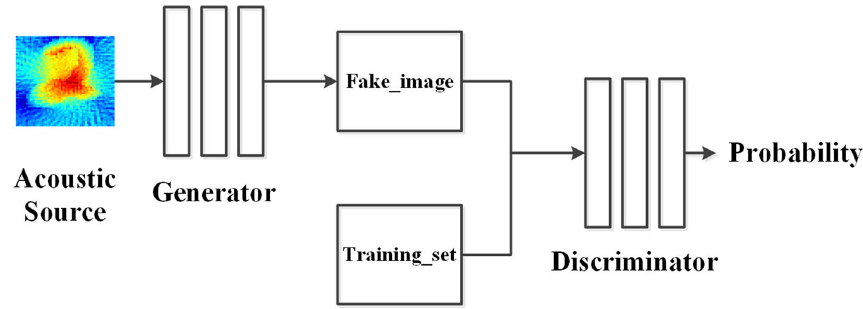
Figure 2. Generative adversarial network principle